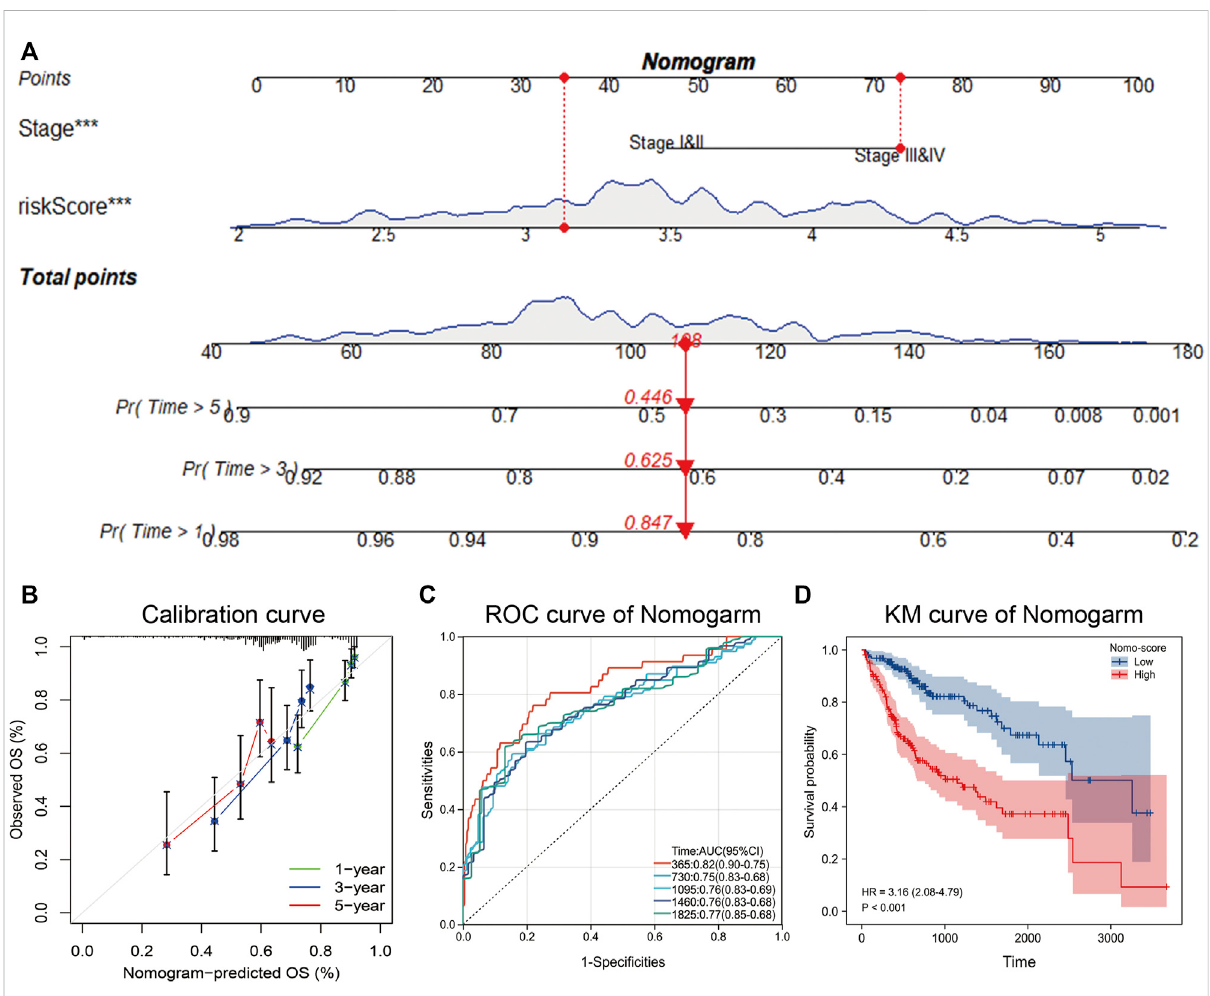
FIGURE 7 Construction of nomogram. (A) Acquisition of survival time and survival status of patients with hepatocellular carcinoma, and construction of nomogram by combining pathological stage and NMRS. (B) Calibration curve of nomogram. (C) Time-dependent ROC curves based on nomo- score. (D) Kaplan-Meier analysis based on